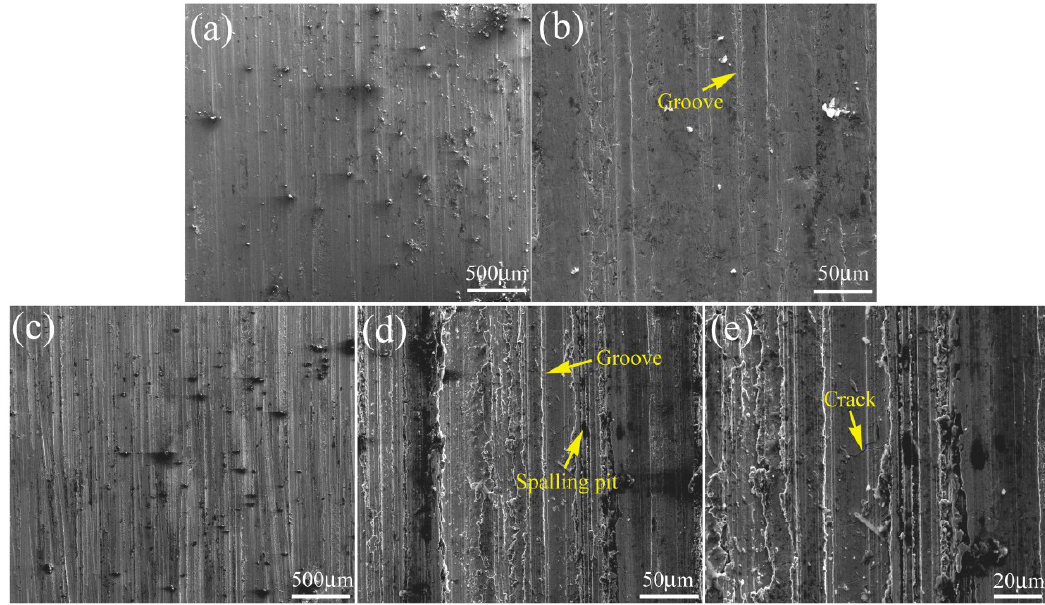
Figure 7. Wear morphology of the various coatings: ( a , b ) Alloy D; ( c – e ) Alloy E.